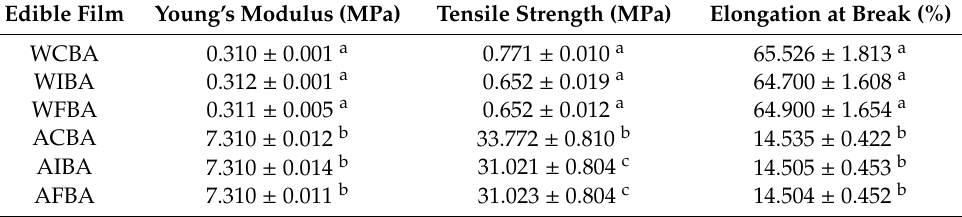
Table 3. Mechanical properties of edible films containing B. animalis subsp. lactis BB-12 and di ff erent types of prebiotics fibres. The data is displayed as mean ± standard deviation of the film samples ( n =